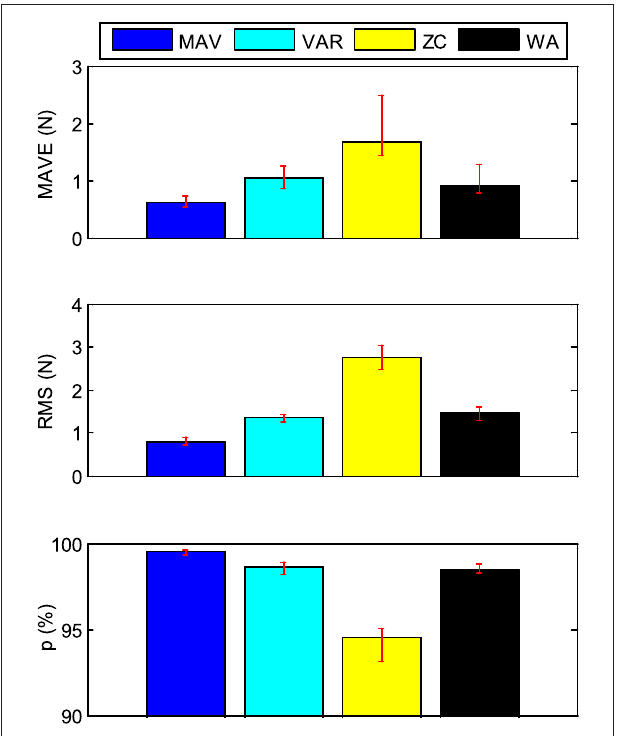
FIGURE 15 | The statistical results of the grip force estimation experiments.